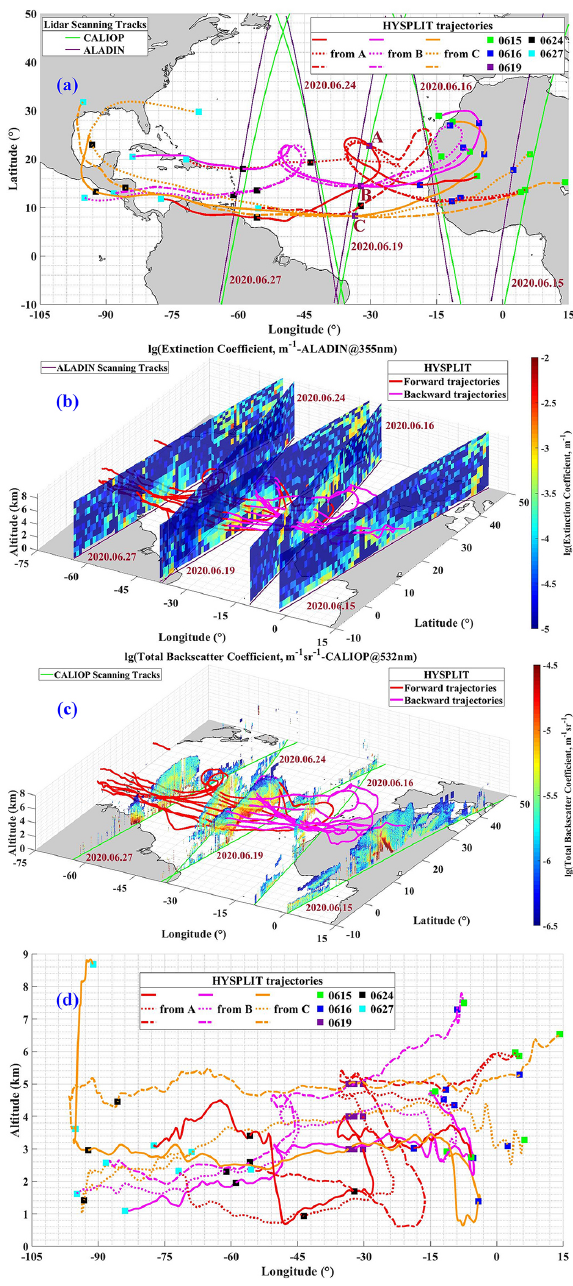
Figure 8. Observation of dust event during 15 and 27 June 2020 with ALADIN and CALIOP and the corresponding HYSPLIT trajectories. (a) Vertical view of ALADIN and CALIOP scan- ning tracks and HYSPLIT trajectories. (b) Extinction coefficient cross-sections measured with ALADIN and HYSPLIT trajecto- ries. (c) Total backscatter coefficient cross-sections measured with CALIOP and HYSPLIT trajectories. (d) Side view of HYSPLIT trajectories. In (a) and (d) , the solid lines, the dotted lines and the dotted–dashed lines of the HYSPLIT trajectories represent the tra- jectories modeled from the altitudes of 3, 4 and